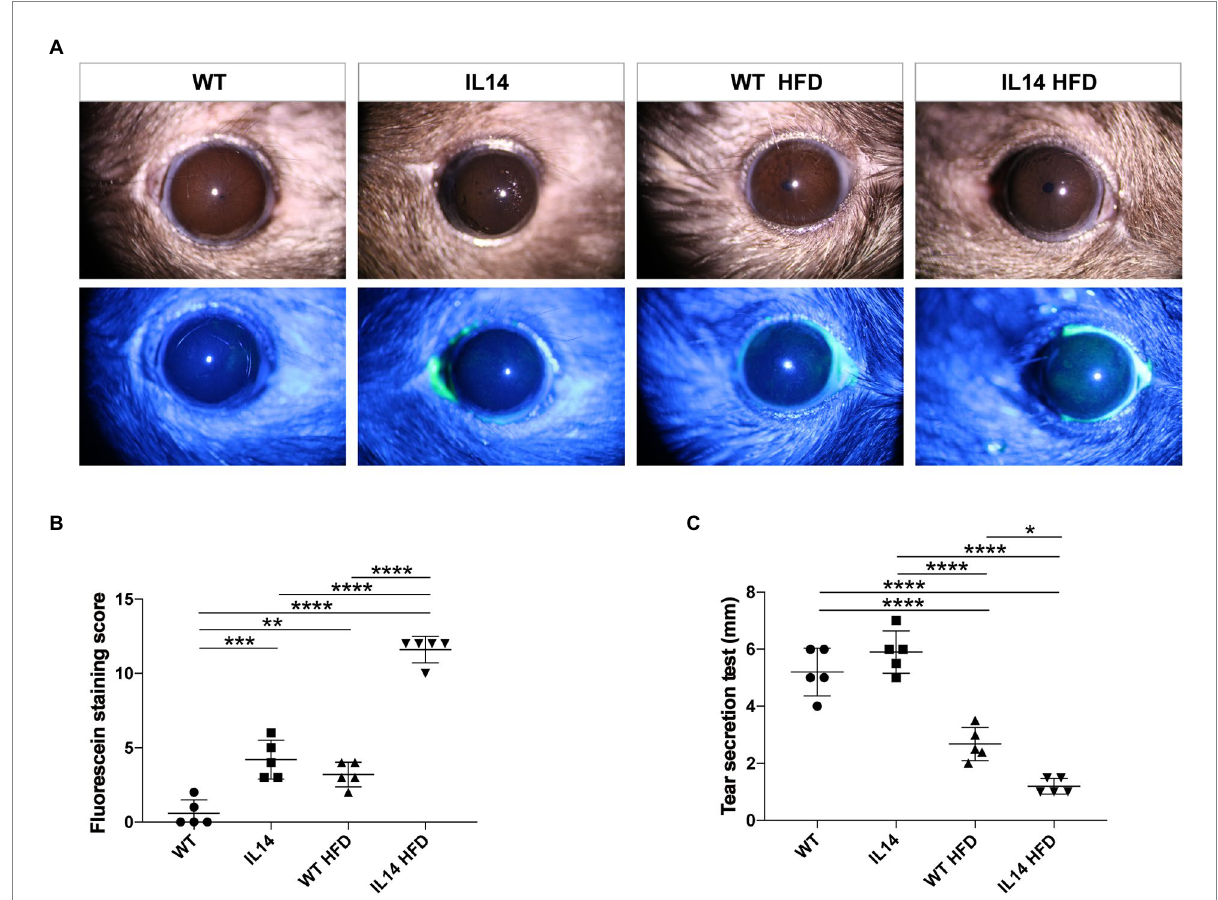
FIGURE 2 HFD aggravated dry eye-like ocular surface damage in the IL-14 α TG mice. The ocular surfaces of the WT, IL14, WT HFD, and IL14 HFD groups were compared using (A) slit-lamp observation and fluorescence staining. (B) The fluorescein staining score showed that the IL14 HFD group was dramatically higher than the other three groups. (C) Tear secretion was measured by the phenol red thread test. * p ≤ 0.05; ** p ≤ 0.01; *** p ≤ 0.005; and **** p ≤ 0.001; n = 5 per